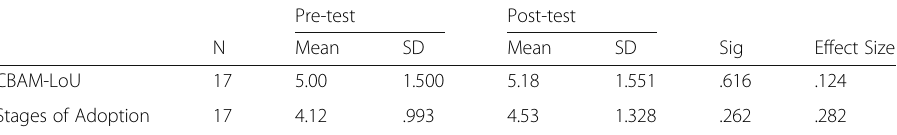
Table 1 T-tests indicating changes in teacher scores prior to and